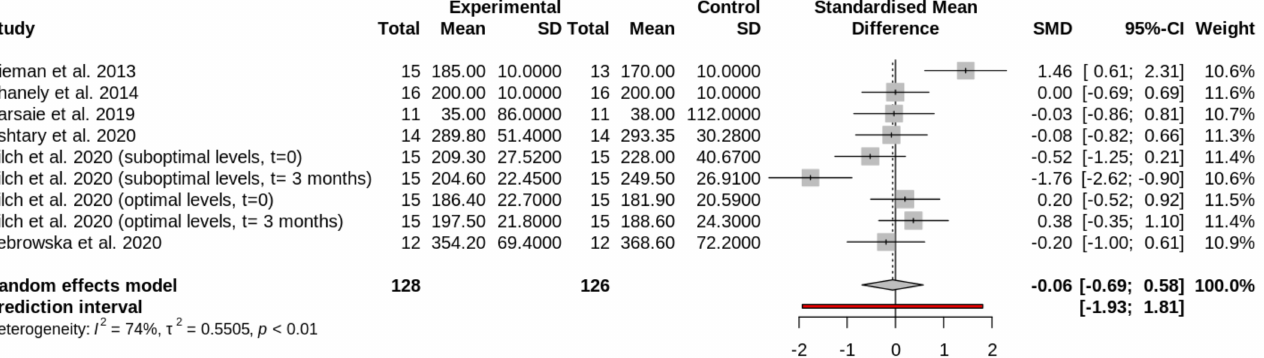
Figure 3. Forest plot comparing the effects of vitamin D supplementation on circulating LDH levels after exercise. The squares in the forest plot on the left side of the line represent studies or groups in which the mean of the experimental group (supplemented) was lower than the mean of the control group (placebo). The ones in the right side indicate the opposite.